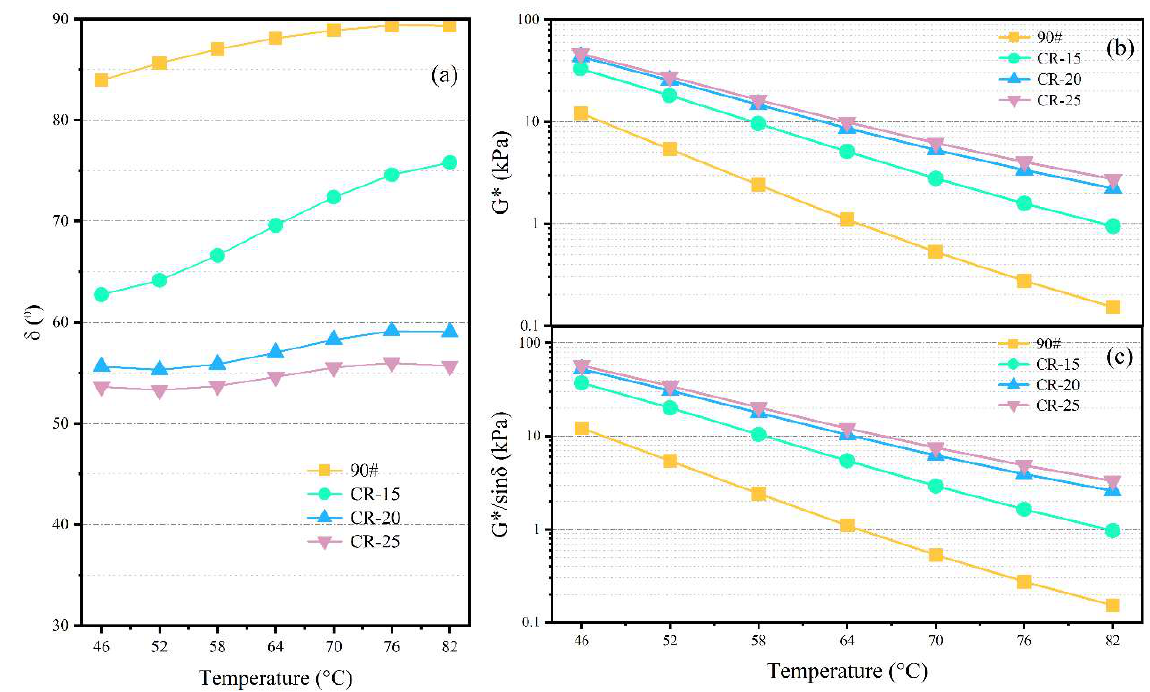
Figure 5. Results of the DSR test: ( a ) δ, ( b ) G*, and ( c ) G*/sin δ.